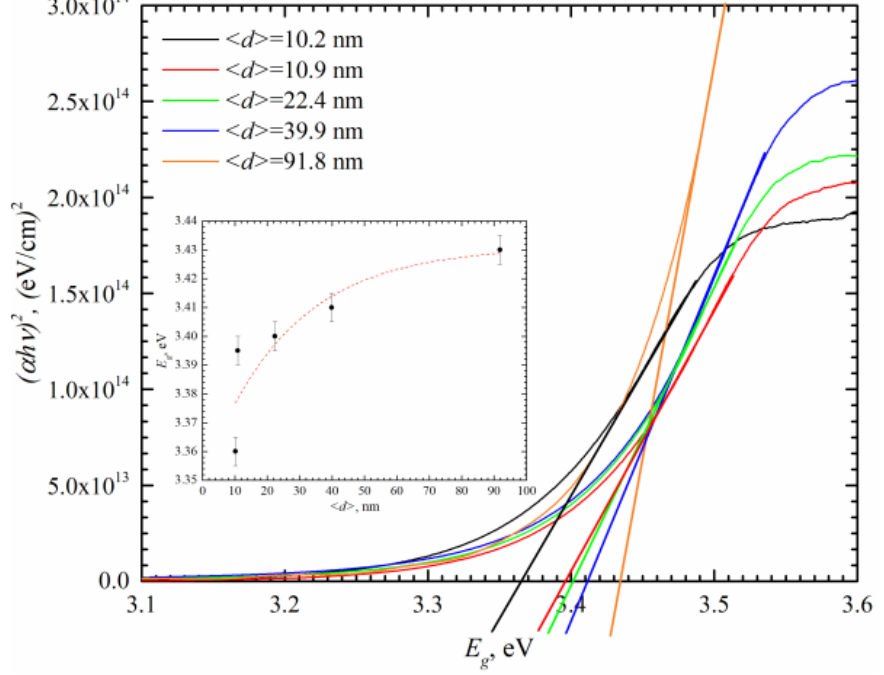
Figure 2. (ℎ𝜈𝛼) 2 dependence on photon energy and band gap ( 𝐸 ( 〈𝑑〉